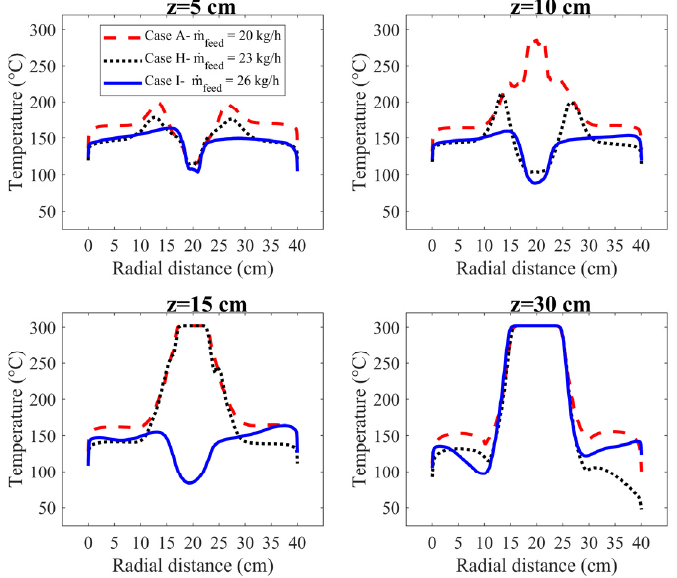
Figure 16. Gas temperature profiles along the radial length of dryer at different distances from the atomizer for centerline of X–Y plane, (where atomizer location is z = 0 cm). Table 7. Particle mean diameter and mean residence time at outlet.